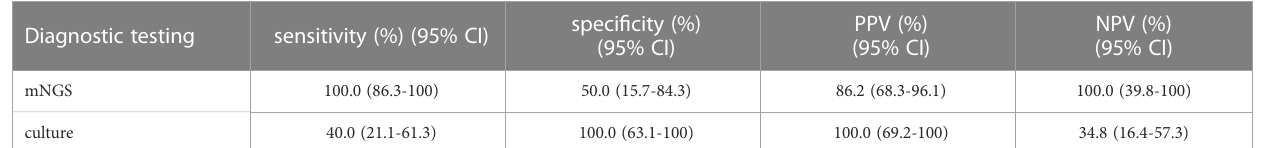
TABLE 4 Performance of mNGS and conventional culture in diagnosis of